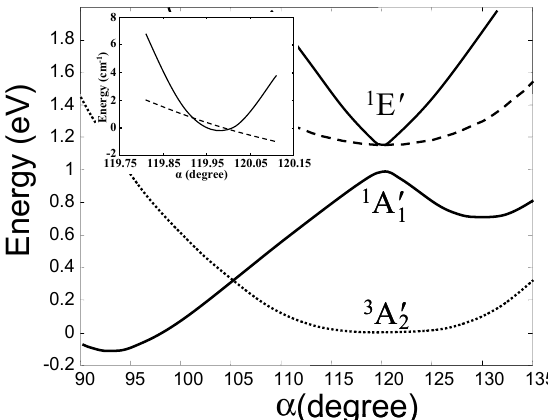
Figure 4. Calculated cross-section of the APES of the planar CuF 3 molecule along the angle α (F-Cu-F) (using the CASSCF method) showing the very weak JTE in the excited E state and a strong PJTE between the E and A states, resulting in the h -PJTE and magnetic-dielectric bistability [6]. The inset shows in more detail the two conical intersections in the E state in this direction.